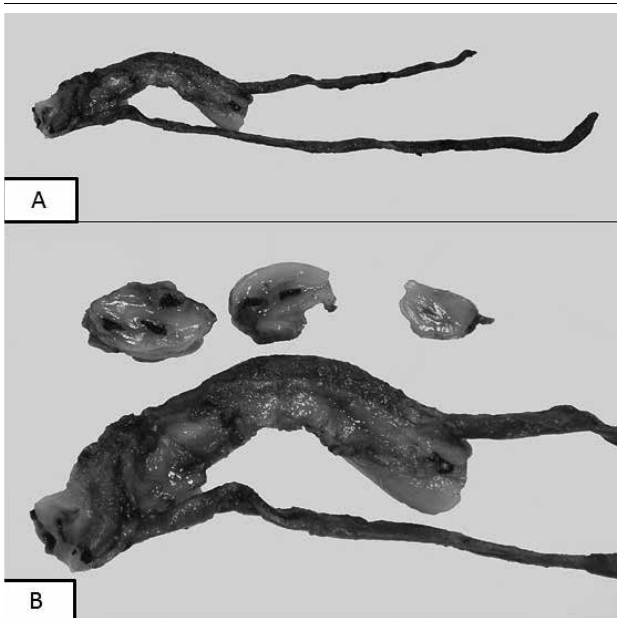
figurE 1 (A and B) − Linear disruption of Wharton’s jelly of the umbilical cord. A green meconium stained segment of umbilical cord showing a long segment of linear disruption of Wharton’s jelly starting about two centimeters below the insertion point, with the three cord blood vessels far away from each